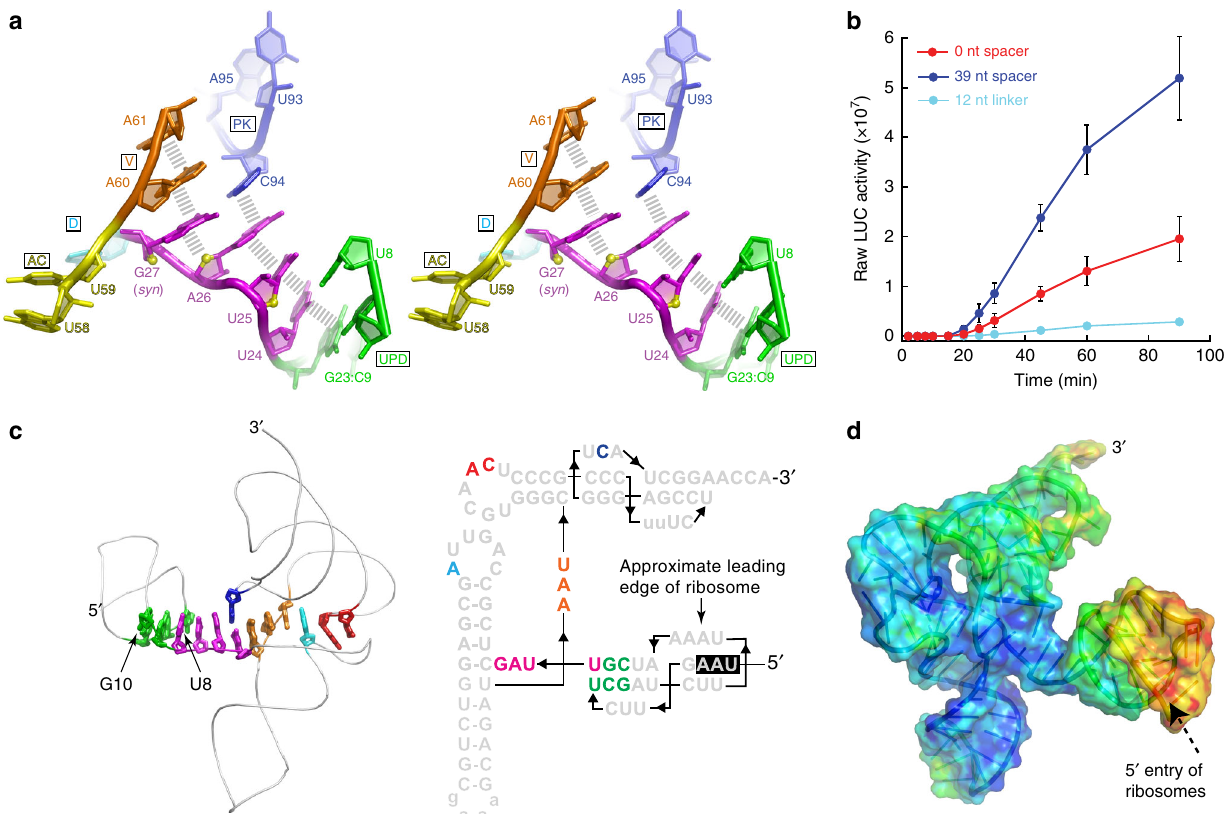
Fig. 7 Interdomain communication and the spine structure. a Stereoview of the linker region and surrounding structure. Yellow spheres indicate the O4 ′ atom to highlight the double inversion. Grey hashes: stacking. The Z-DNA-like motif is found in the syn -G27 and A26 step. b In vitro translation assays of a reporter with the interdomain linker length increased to 12 nucleotides. Data from two different spacers is included for comparison. Error bars represent one s.e.m. of n ≥ 3 replicates. c Left: A spine of continuously stacked bases extends from the UPD to the T-loop. Nucleotides in the spine are shown in stick representation (colored to match Fig. 5, G10C and U8A positions are shown). Right: Secondary structure of the TLS + UPD, with nucleotides visible to the left highlighted and colored to match. The stop codon in the UPD is boxed in black. The location of the leading edge of the ribosome when the stop codon is in the A site is shown. d Surface representation of the structure colored by relative crystallographic B -factor, with red highest and blue